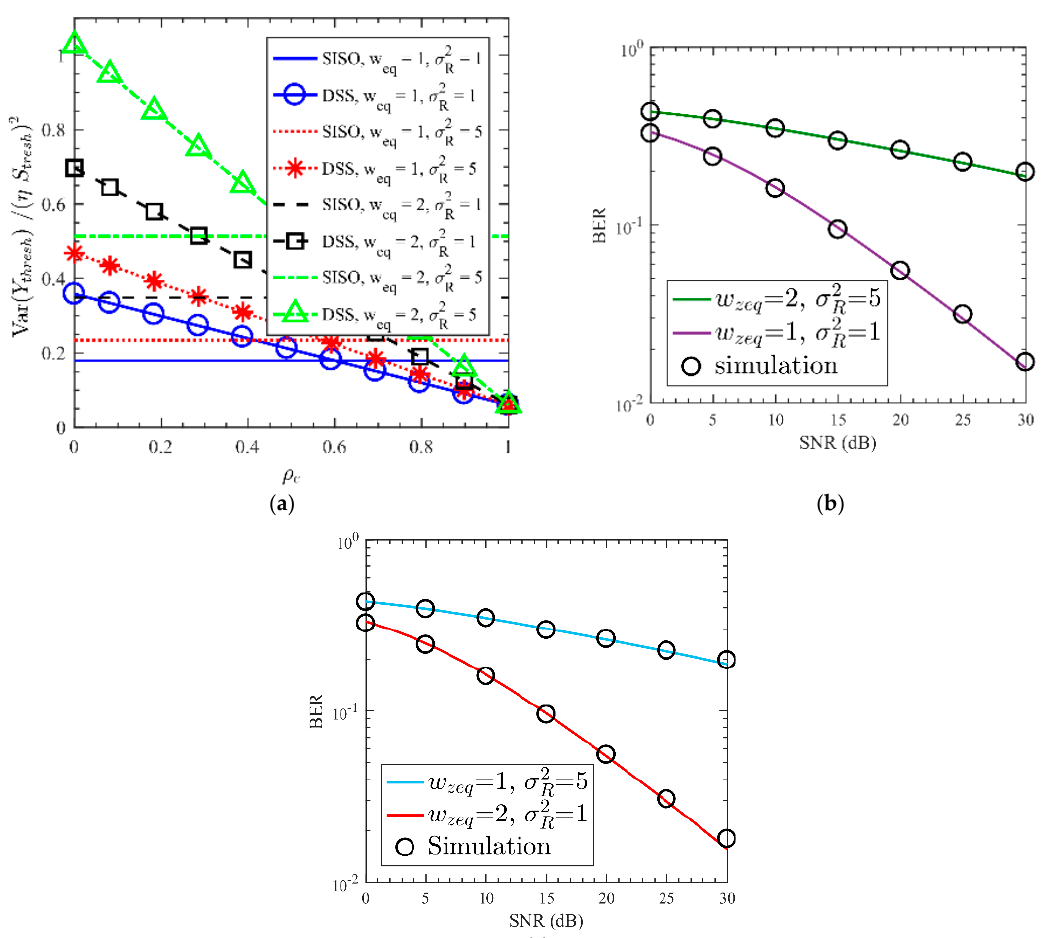
Figure 6. Single-input single-output (SISO) and differential signaling scheme (DSS) based free-space optical (FSO) links with pointing errors (PE) and moderate to strong turbulence: ( a ) the normalised variance of detection threshold level (DTL) versus the correlation coefficient of the channels; and ( b , c ) bit-error-rate (BER) against signal-to-noise ratio (SNR) for different values of w eq with unit of cm and σ 2 R